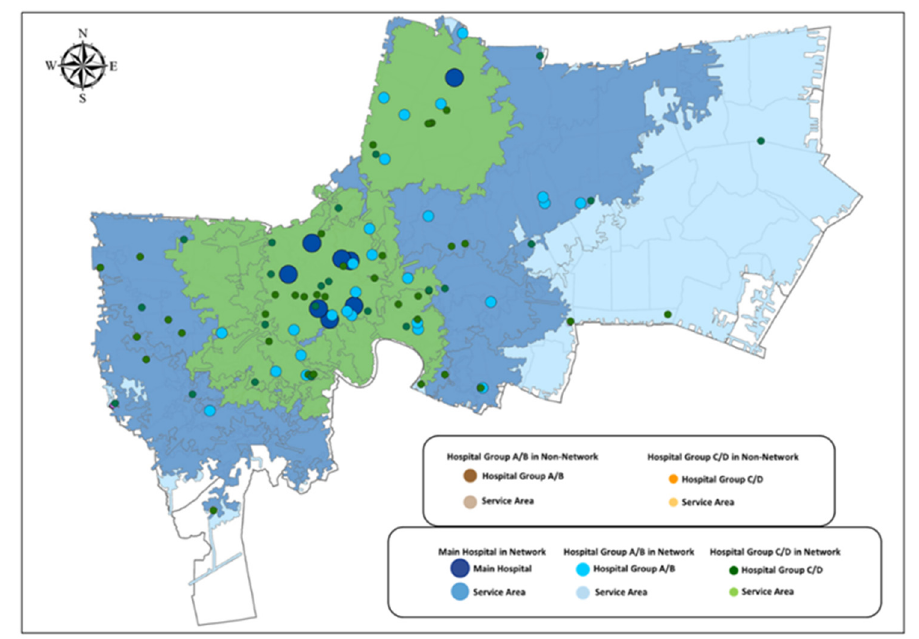
Figure 14. Service area of network hospitals.